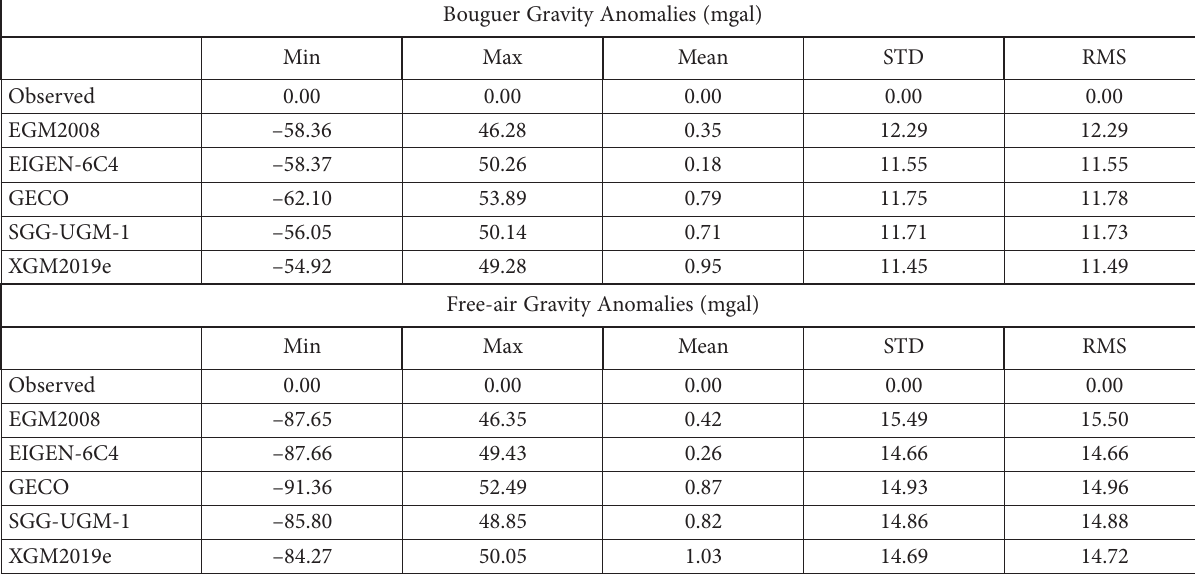
Table 5. Statistics of differences between the ground-based and tailored GGM-derived Bouguer and free-air gravity